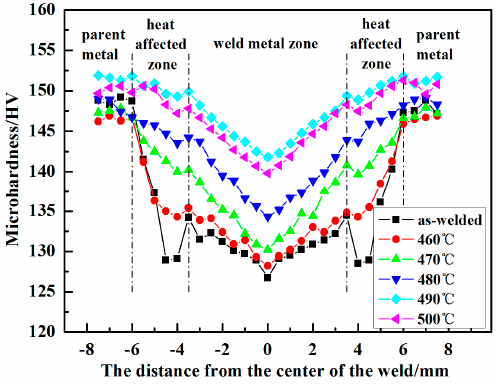
Figure 9. Microhardness distribution of welded joints between as-welded and PWHT with solution at different temperatures for 60 min followed by aging at 120 °C for 24 h.